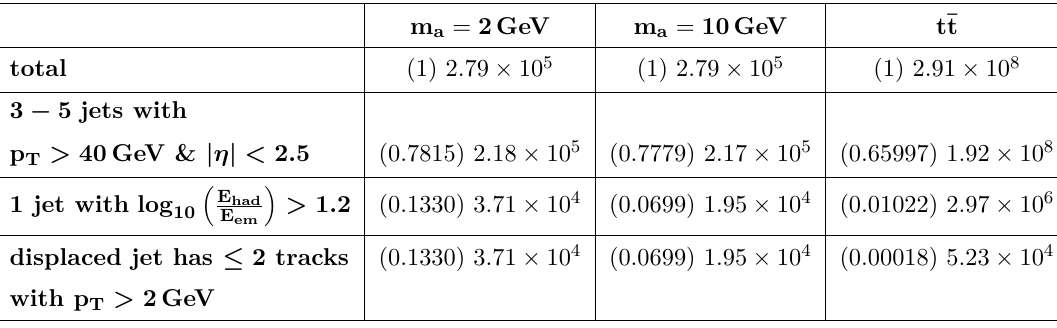
Table 2 . Cut flow of the expected number of events for signal and background events for LHC run √ 3 with s = 13 TeV and L = 350 fb − 1 . The values in brackets are the efficiencies after each cut. For the signal cτ ALP = 0 . 1 m and Br( t → aq ) = 0 . 001 was